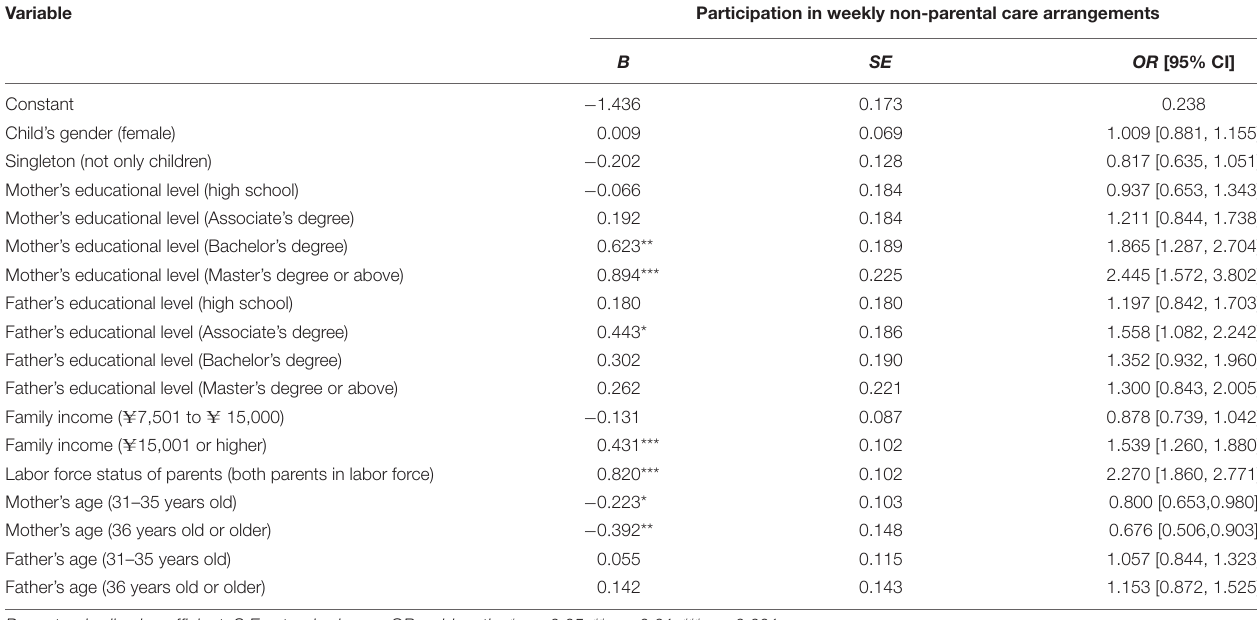
TABLE 2 | Logistic estimates for the likelihood of weekly non-parental care arrangements participation.